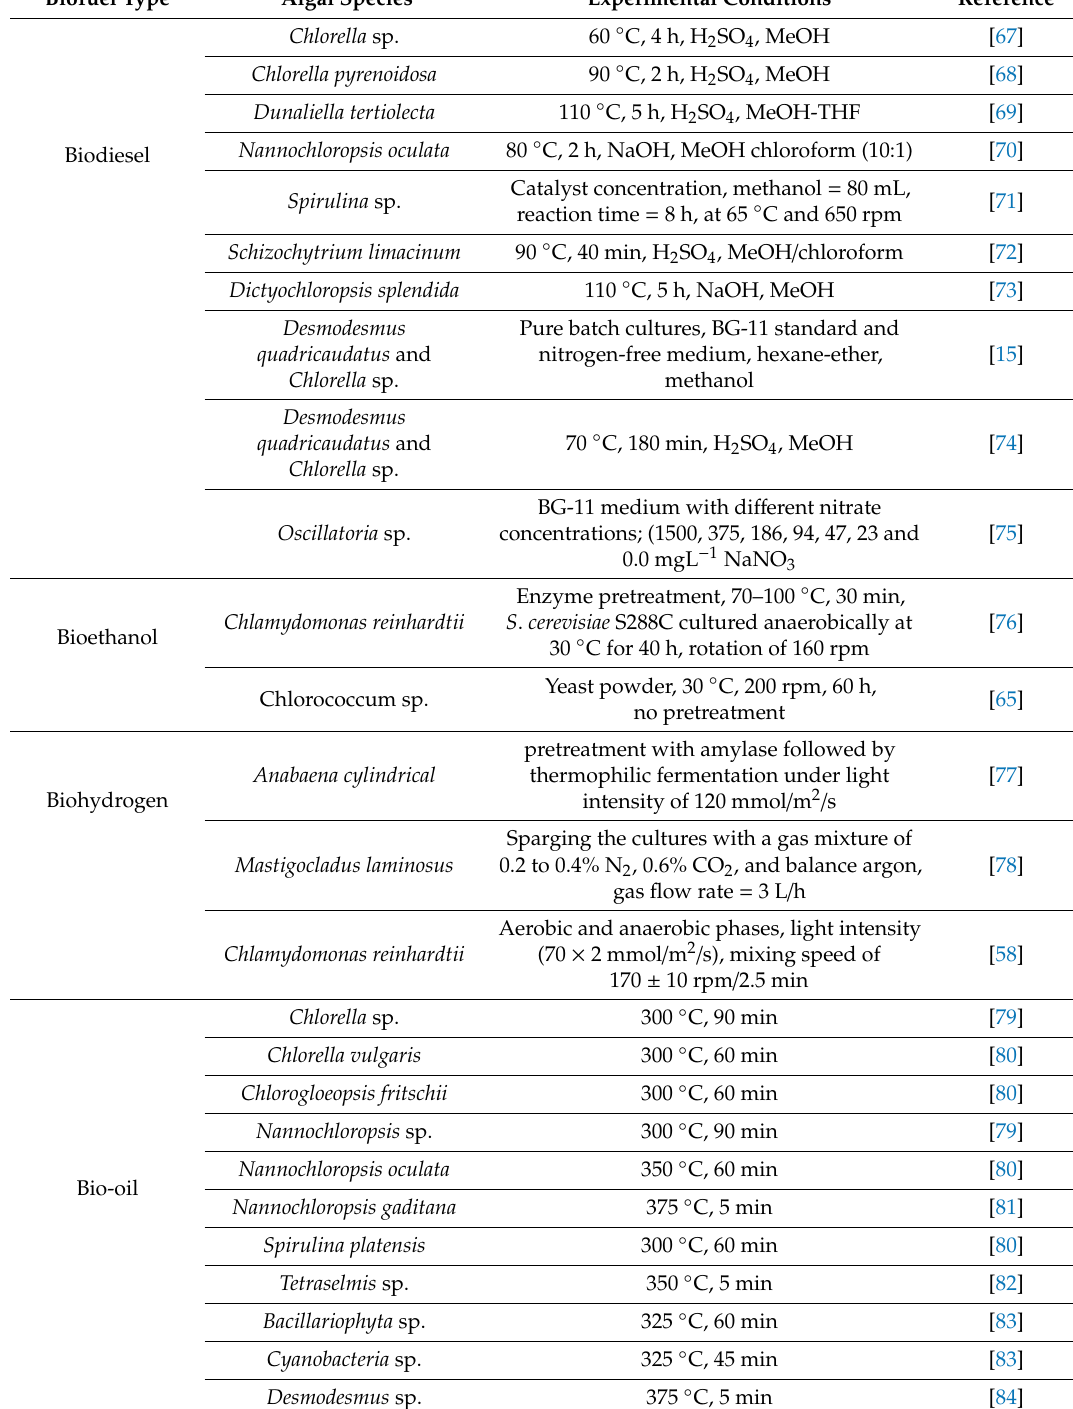
Table 3. Oil, gas, and char from di ff erent algae